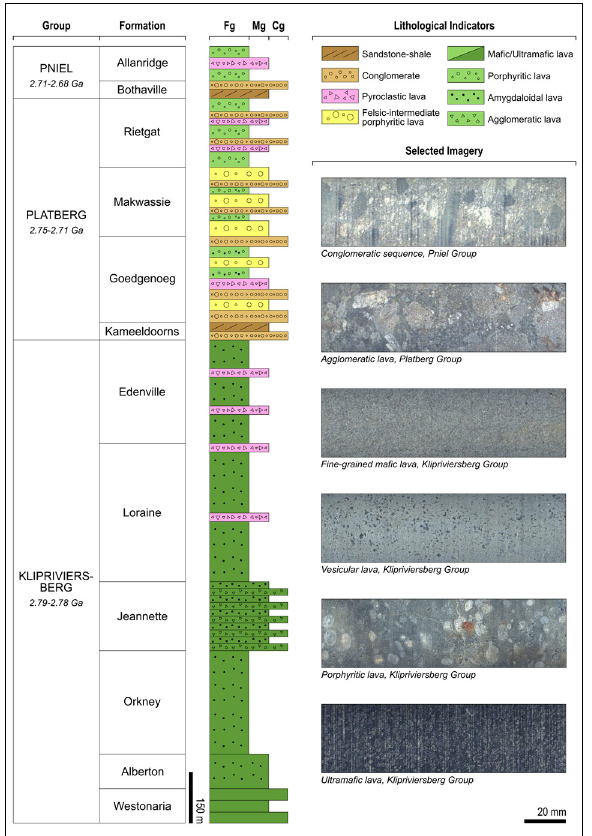
Figure 3: Generalised stratigraphic column of the Ventersdorp Supergroup. Fg, Mg and Cg refers to fine-grained, medium-grained and coarse-grained, respectively. Geological information gathered from various sources. 26,29,36-38 Images from samples at the Council for Geoscience National Core Library.